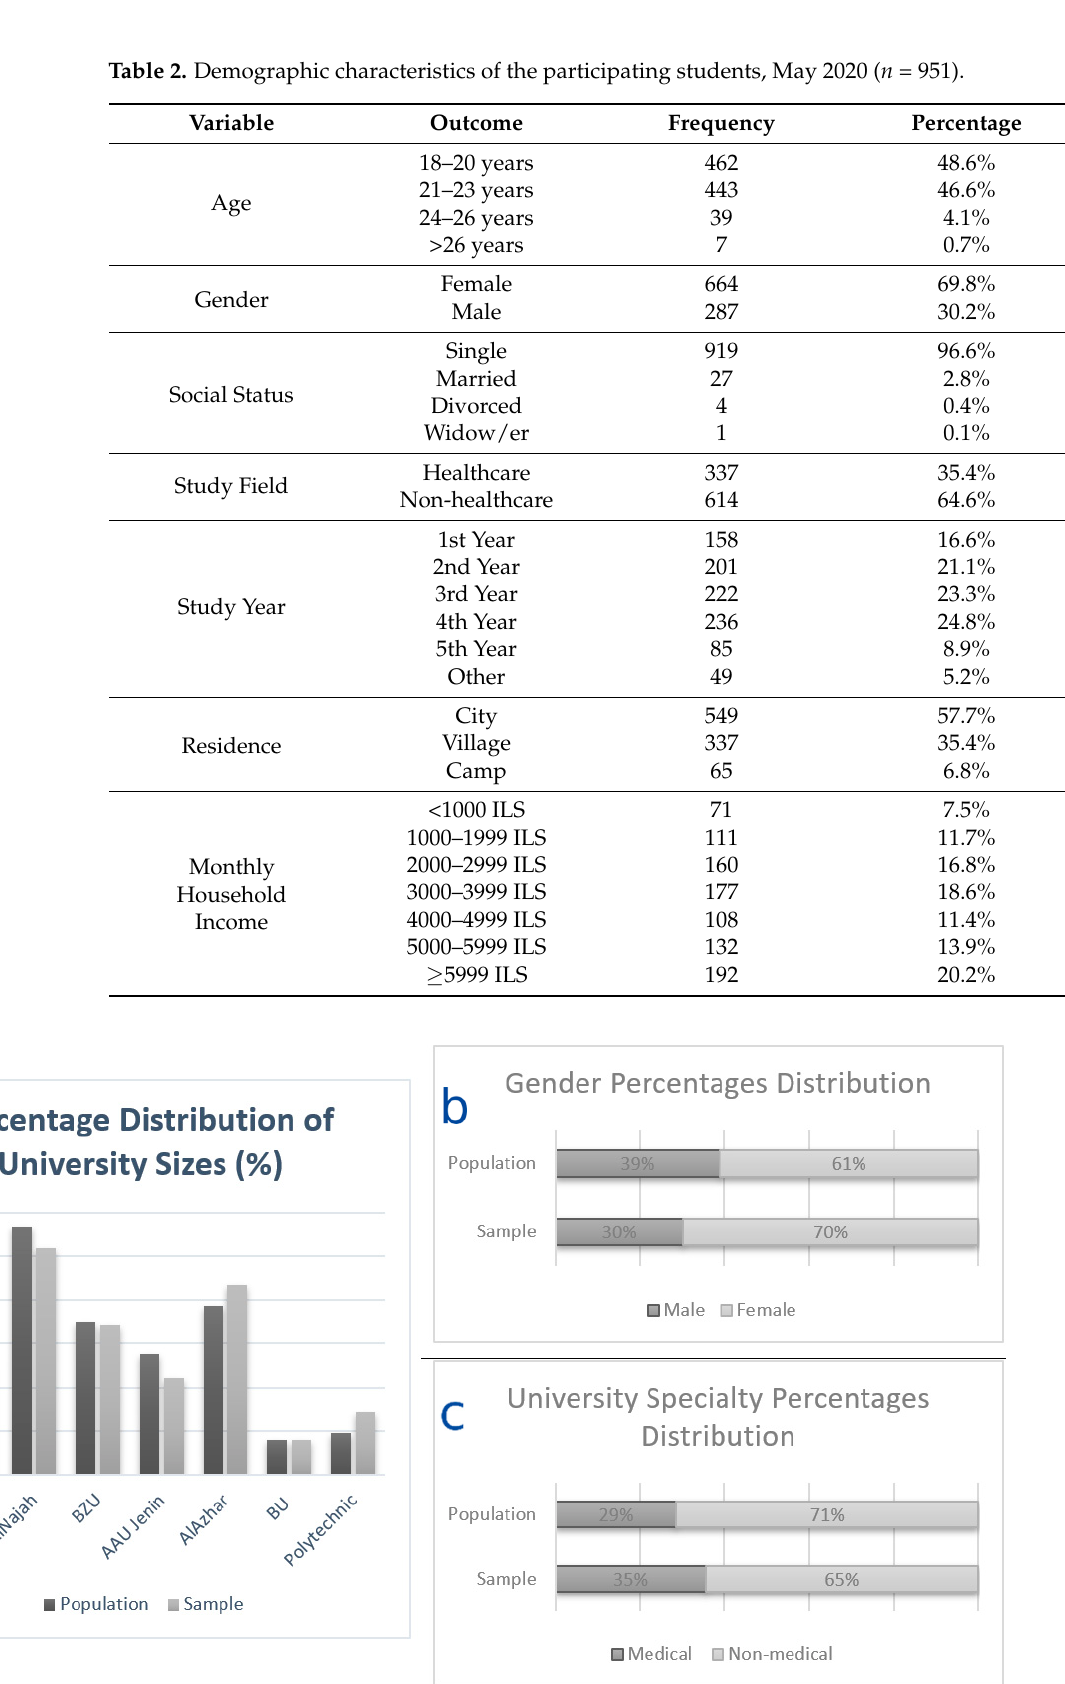
Figure 1. Response rate and representativeness of the participating students: ( a ) response rate; and ( b ) representativeness by gender and ( c ) by study program.